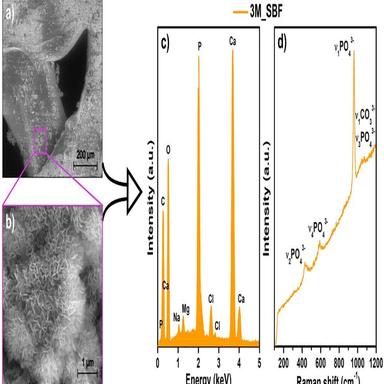
Selected SEM images of Bioflex® printouts after 3 months of incubation in SBF (a,b), and corresponding EDS (c) and Raman (d) spectra of formed crystals. Ca/ P ratio is equal to 1.57. SEM images after 1 week and 1 month of incubation can be found in Table S6 (supplementary data).